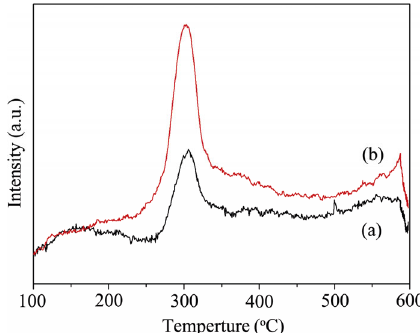
Fig. 6 NH 3 -TPD profiles of the catalysts: (a) MnO x – CeO 2 /TiO 2 and (b) MnO x –CeO 2 /TiO 2